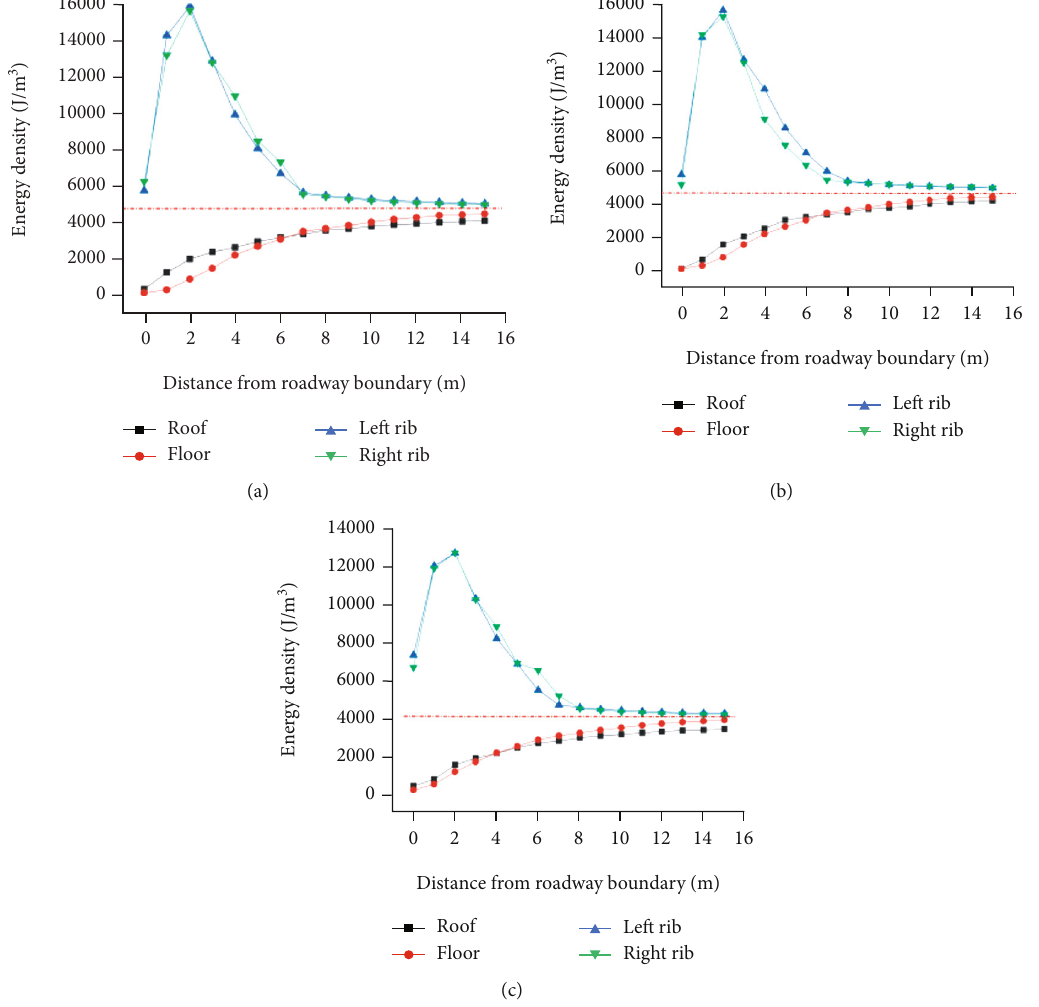
Figure 9: Energy density change curve under di ff erent support methods. (a) No support. (b) Original support. (c) Combined